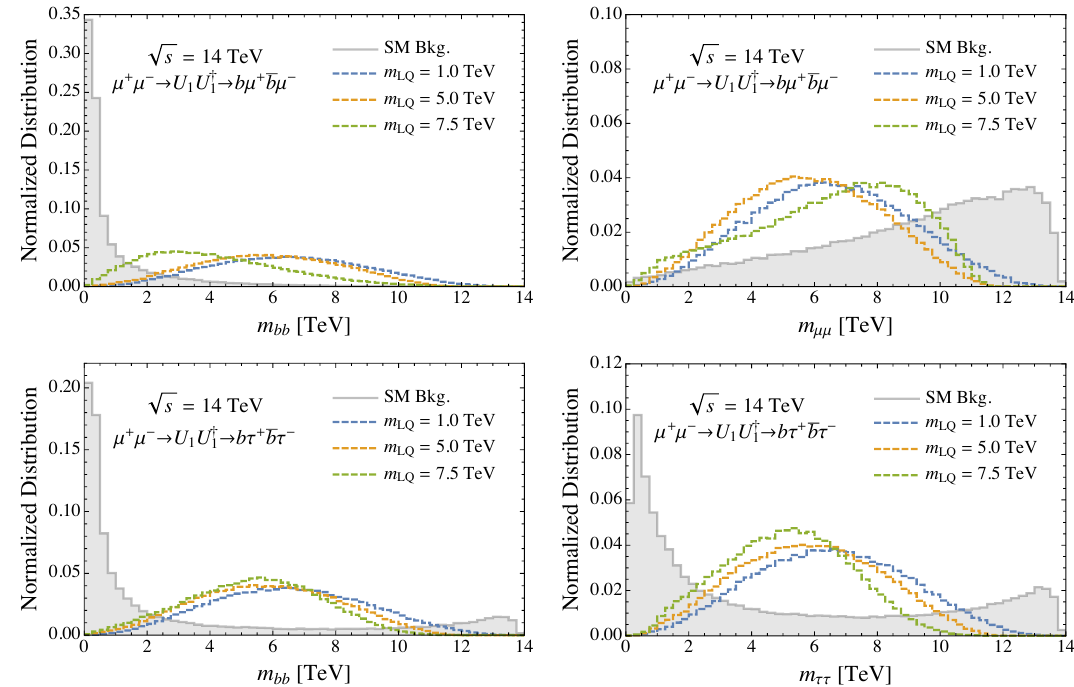
Figure 3 . Normalized distributions of the invariant mass for particle-antiparticle pairs in the SM background (gray shaded) and for LQ PP signals. We use β 32 = 0 . 1 in all the figures. The left two L panels show the m bb distribution, while the right two panels show the m µµ (top) and m ττ (bottom) distributions. The upper two panels correspond to flavor scenario 1, with bbµµ final states, while the bottom two panels correspond to flavor scenario 3, with bbττ final states. The histograms motivate cuts on m bb for improving the signal-to-background ratio; see the text for further